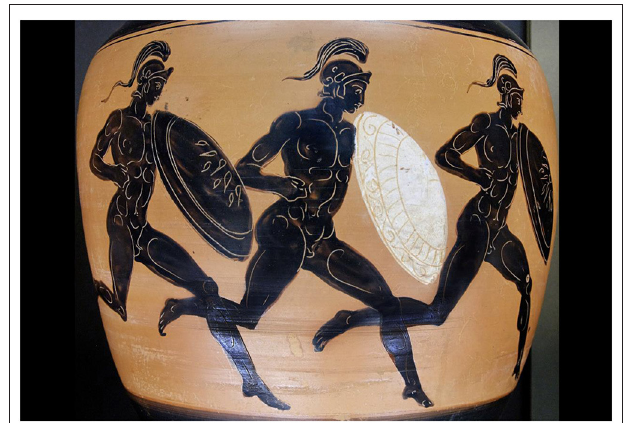
FIGURE 1 | Depiction of runners during the Panatheniaic games 323-322 BC. Note the forefoot strike pattern of the runners. https://en.wikipedia.org/wiki/